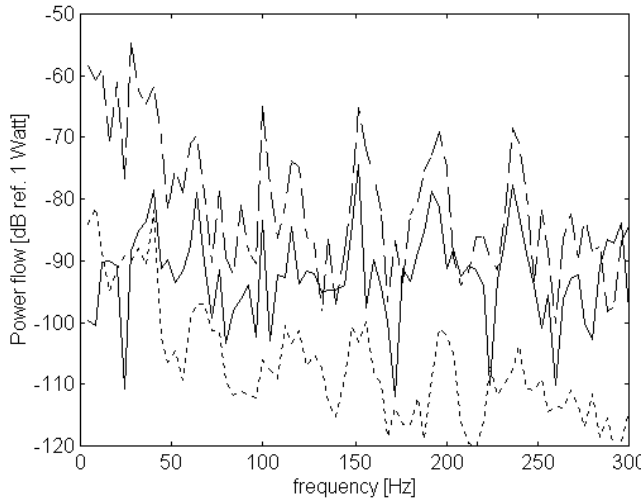
Fig. 6. SI components measured using the LDV. - - - Flexural SI; — longitudinal SI; ··· torsional SI.